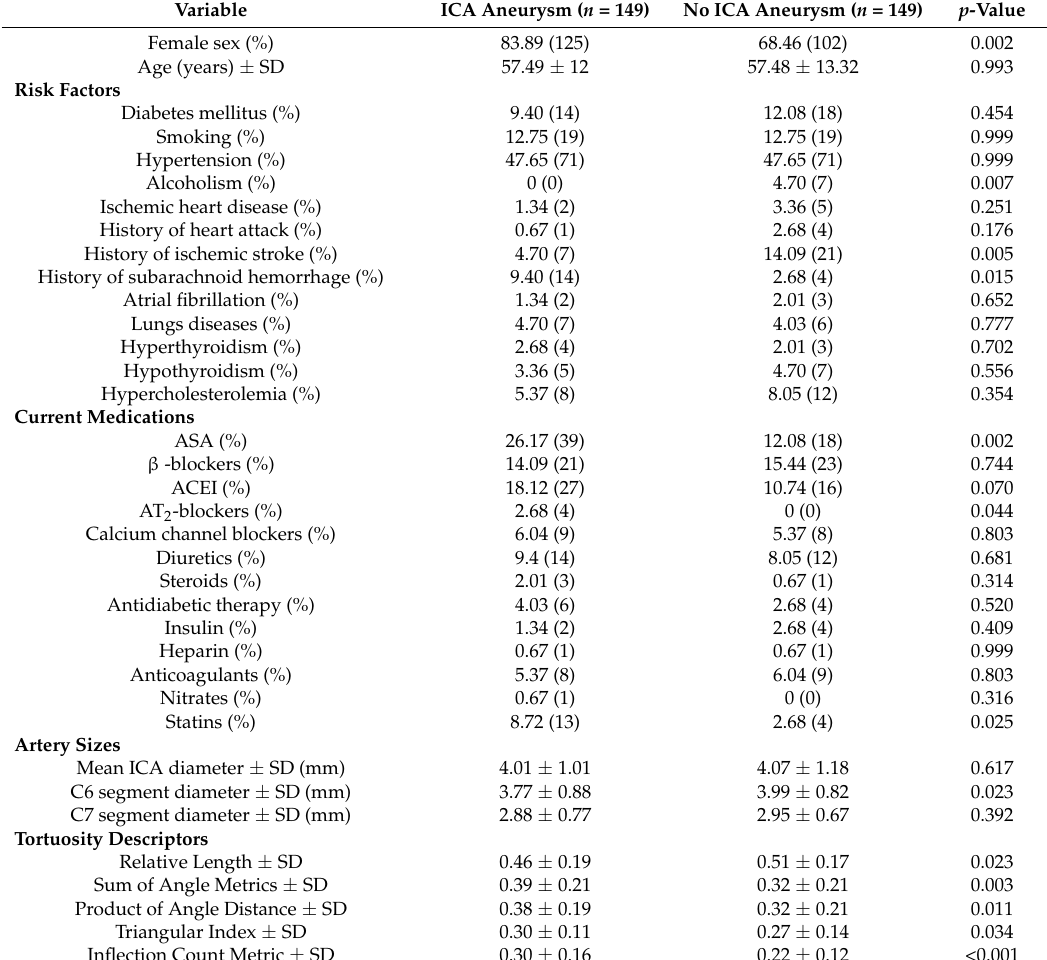
Table 1. Comparison of risk factors and tortuosity descriptors between patients with and without internal carotid artery